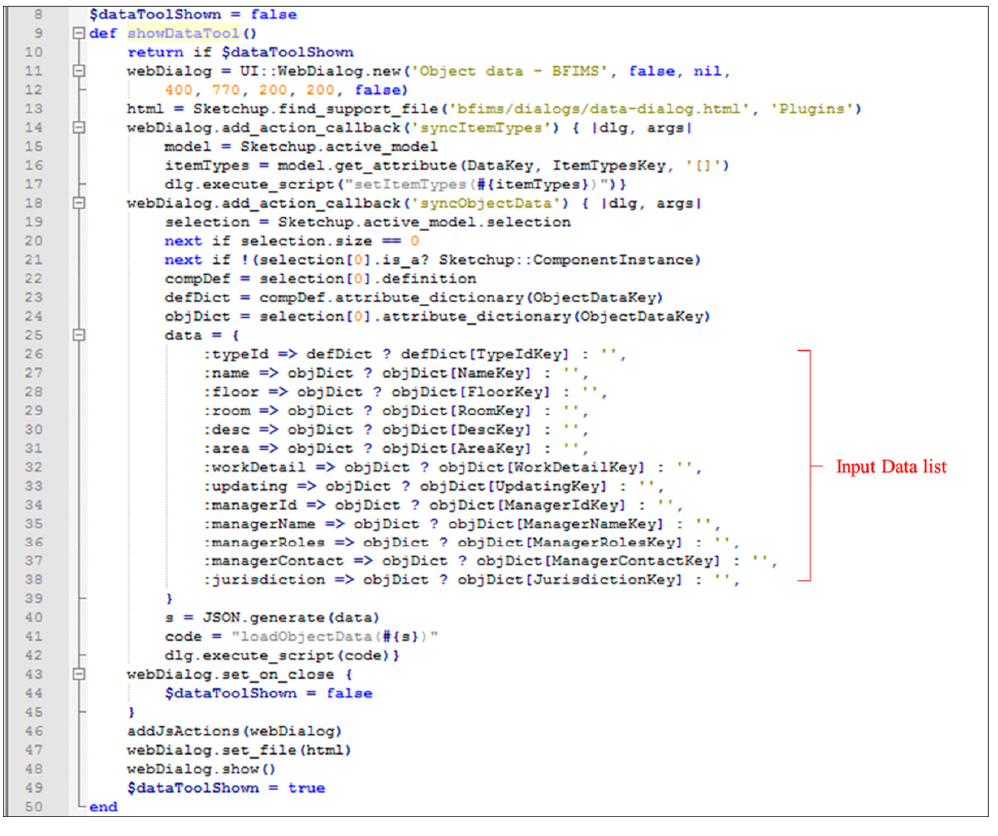
Figure 6. System code: Object data input.